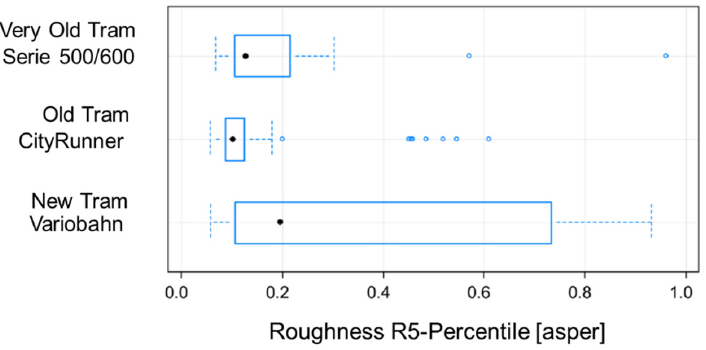
Figure 11. Roughness R5 ‐ Percentile in (asper) at each measuring point for all passing tramways.